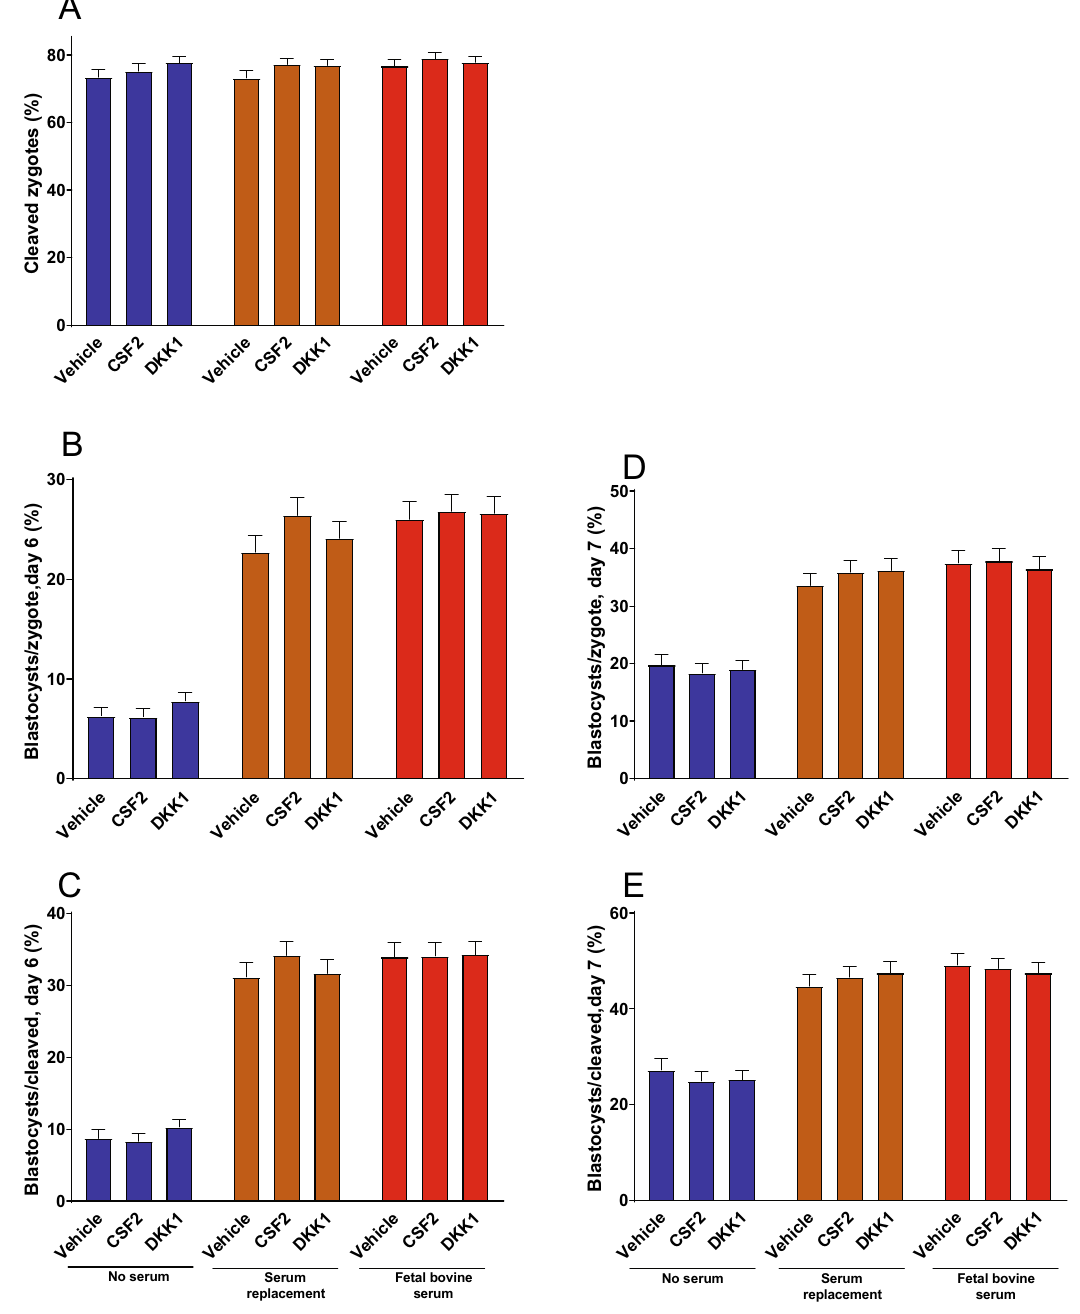
Figure 1. Effects of medium and embryokine treatments on development of bovine embryos. Cleavage was measured at day 3 ( A ) and development to the blastocyst stage at day 6 ( B , C ) and 7 ( D , E ). Media treatments were no serum, serum replacement (SR) and fetal bovine serum (FBS). Embryokine treatments were added at day 5 and were vehicle, colony stimulating factor 2 (CSF2) and dickopf WNT signaling pathway inhibitor 1 (DKK1). Shown are least-squares means ± SEM. Cleavage rate was affected by medium (P = 0.029) and embryokine (P = 0.008). Using contrasts, cleavage was higher (P = 0.027) for FBS than SR. Cleavage was also lower (P = 0.012) for vehicle than for CSF2 or DKK1. The proportion of embryos that became blastocysts at day 6 ( B , C ) or day 7 ( D , E ), whether expressed as the percent of putative zygotes ( B , D ) or cleaved embryos ( C , E ), was affected by medium (P < 0.0001). Further analysis using orthogonal contrasts indicated that more embryos became blastocysts in media with SR or FBS than for no serum (P < 0.0001).The total number of putative zygotes/treatment were 945 for no serum—vehicle, 1165 for no serum—CSF2, 1216 for no serum DKK1, 1288 for SR—vehicle, 1416 for SR and CSF2, 1526 for SR and DKK1, 1288 for FBS and vehicle, 1551 for FBS and CSF2, and 1593 for FBS and